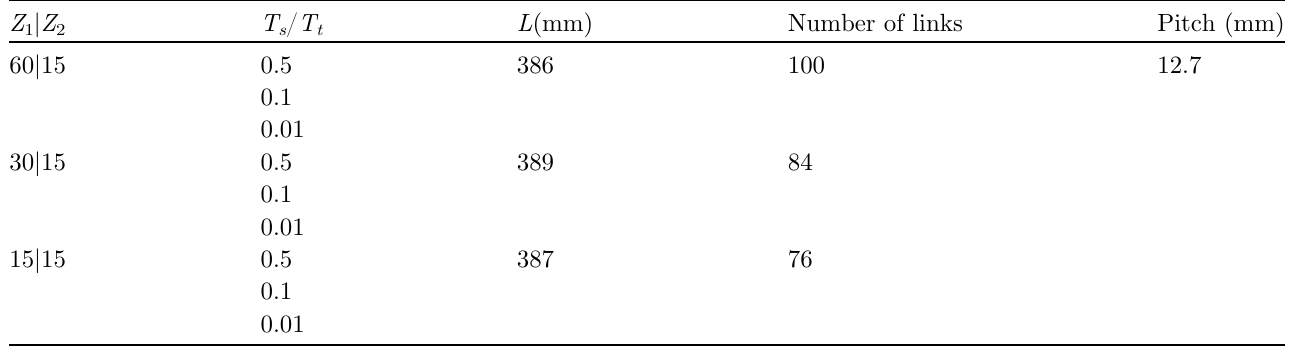
Table 2. Characteristics of the tested drive con fi gurations.